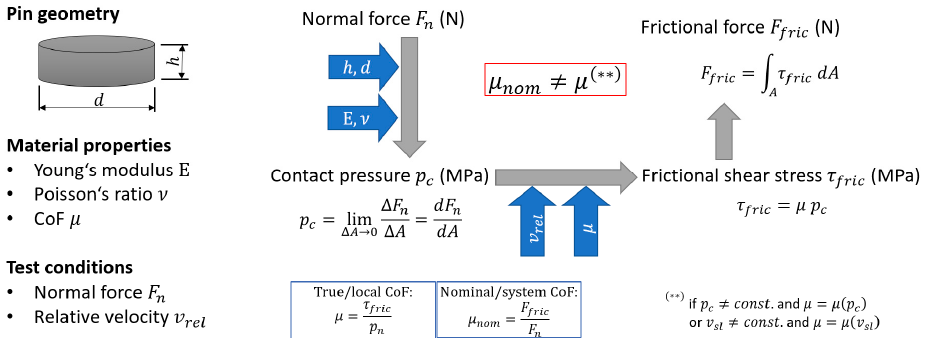
Figure 1. Comparison between nominal and true coefficient of friction for arbitrary contact pressure distributions and materials with pressure und velocity dependent frictional behavior.